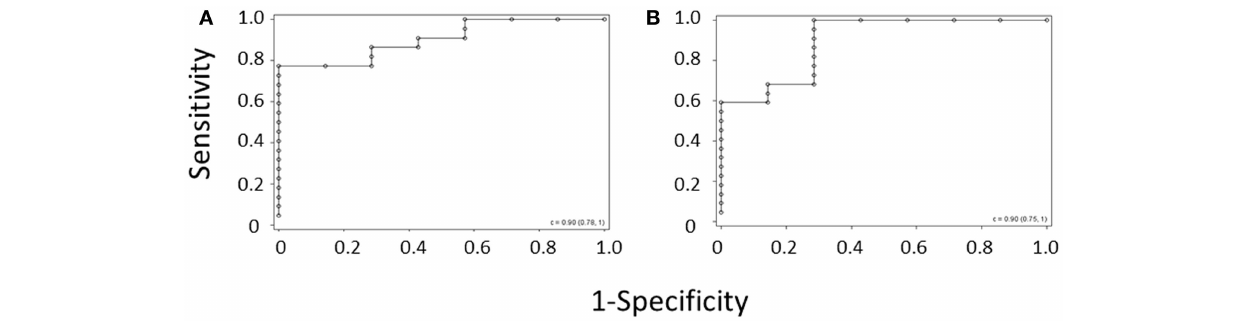
the observed differences, and so the persistence of statistically significant differences between WAS and ITP subjects argues that this source of error did not lead to important